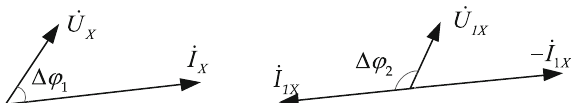
Fig. 6 The pre- and post-fault current and voltage vector graphs of X terminal of situation (3)